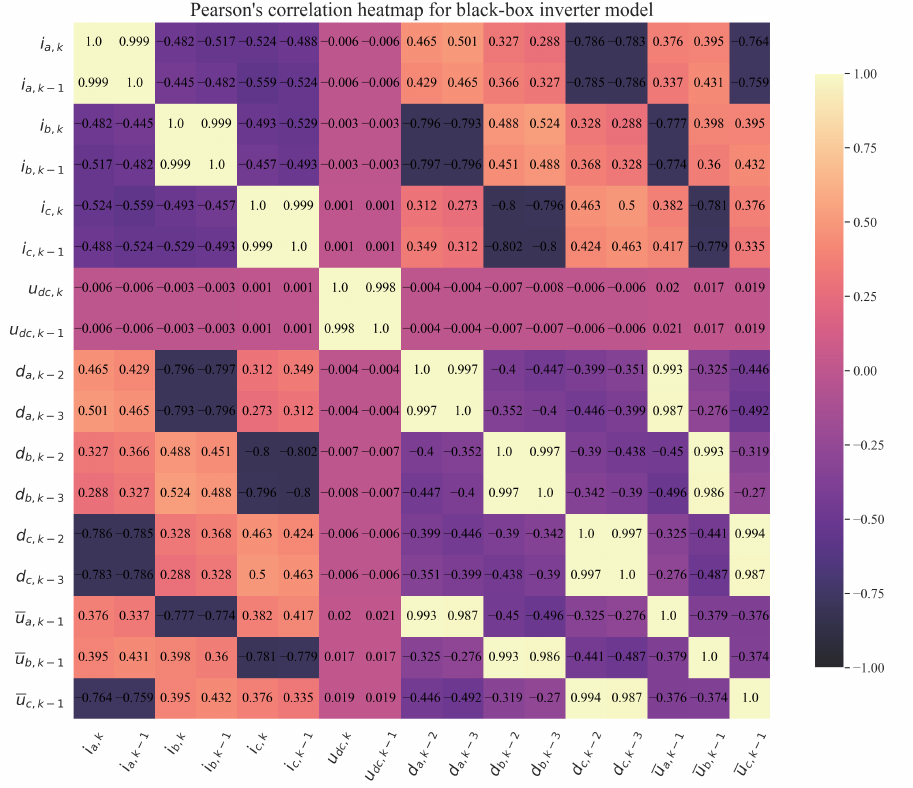
Figure 4. Pearson’s correlation heat-map for black-box inverter